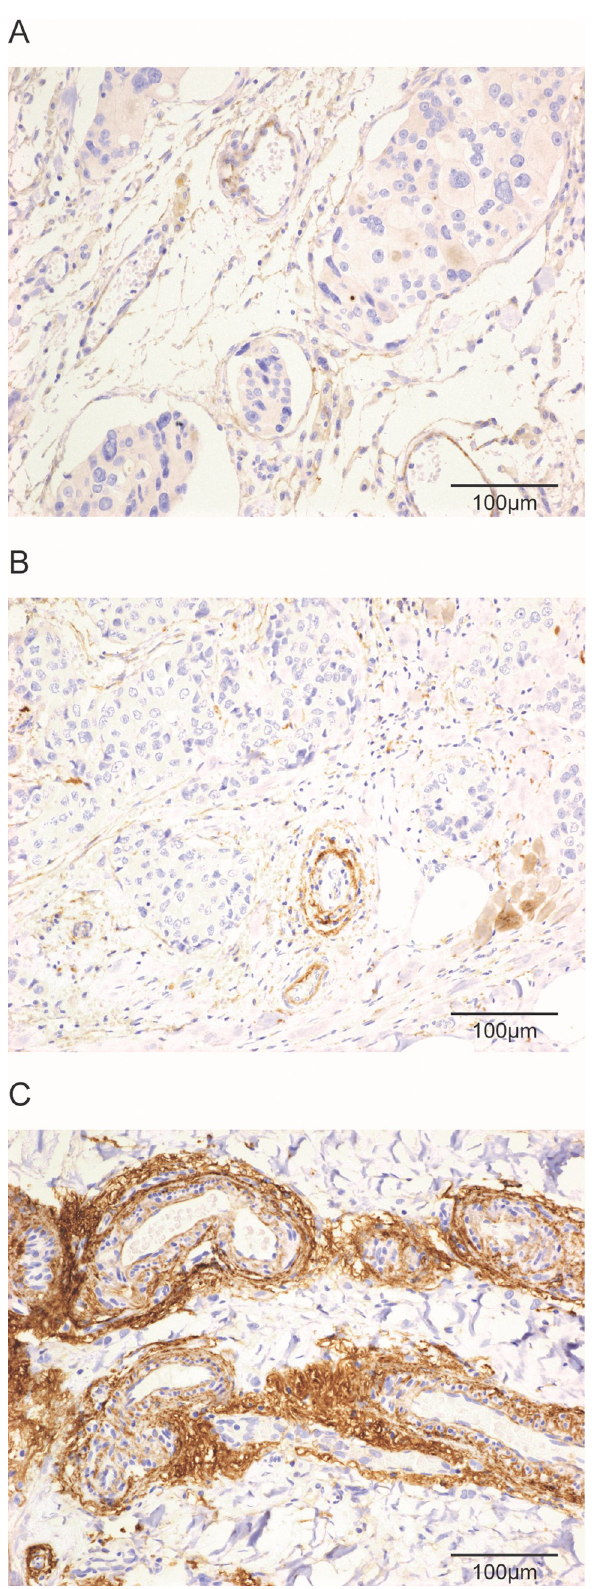
Fig 1. Histological images of perivascular fibulin-2 expression by immuno-histochemistry. Histological images of tumour tissue with absent or faint/barely perceptible peripheral staining in tumour vessels (A), weak to moderate